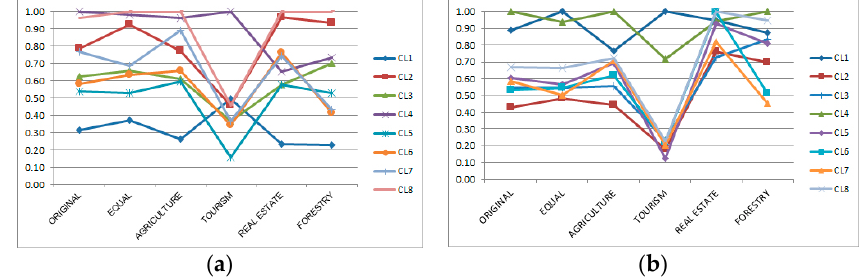
Figure 7. Results of sensitivity analysis for MAI landscape context for LEA (a) and SLEA (b) indices. Table 11. Results of sensitivity analysis for LEA and SLEA indices of the MAI landscape.